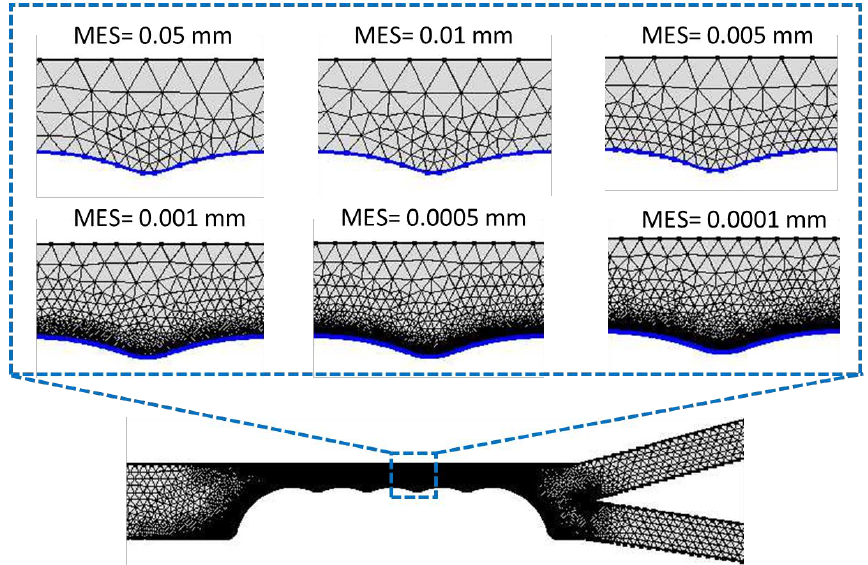
Figure 4. The discretization of the separation region, i.e., along the semicircular constrictions where maximum DEP effect is observed that causes the cells to move into categorized streamlines by adopting variable mesh element size (MES).